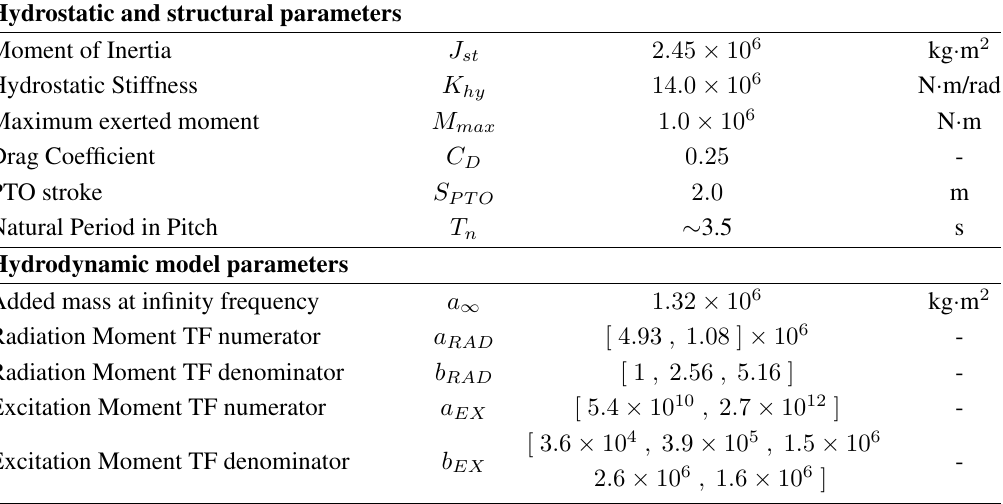
Table 2. Model parameters for the Wavestar WEC [10,30,45]. TF: transfer function. Hydrostatic and structural